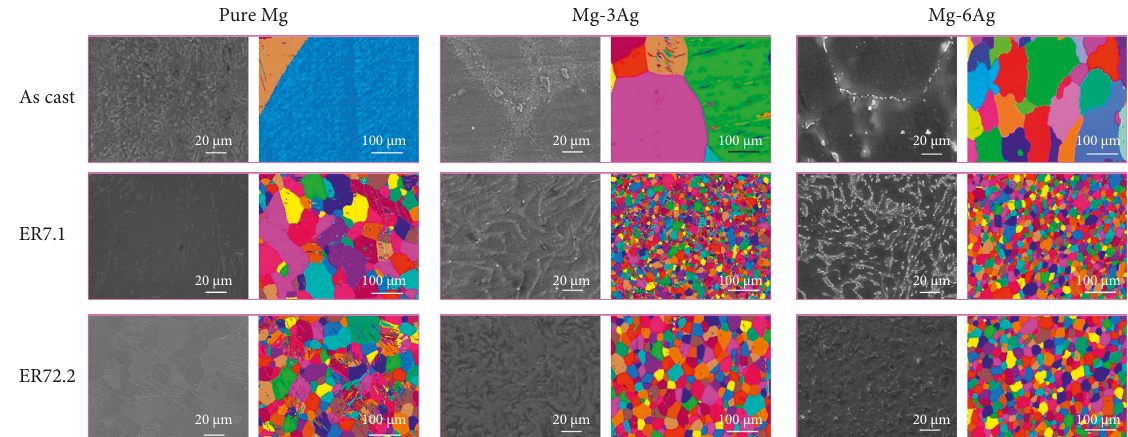
Figure 1: Microstructure of pure Mg, Mg-3Ag, and Mg-6Ag with different extrusion ratios: 1 (as cast), 7.1, and Table 2: Average proportion of precipitates and grain sizes of samples.